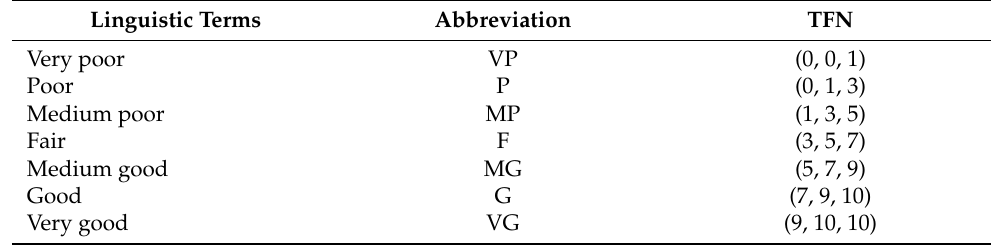
Table 5. Linguistic terms for alternative